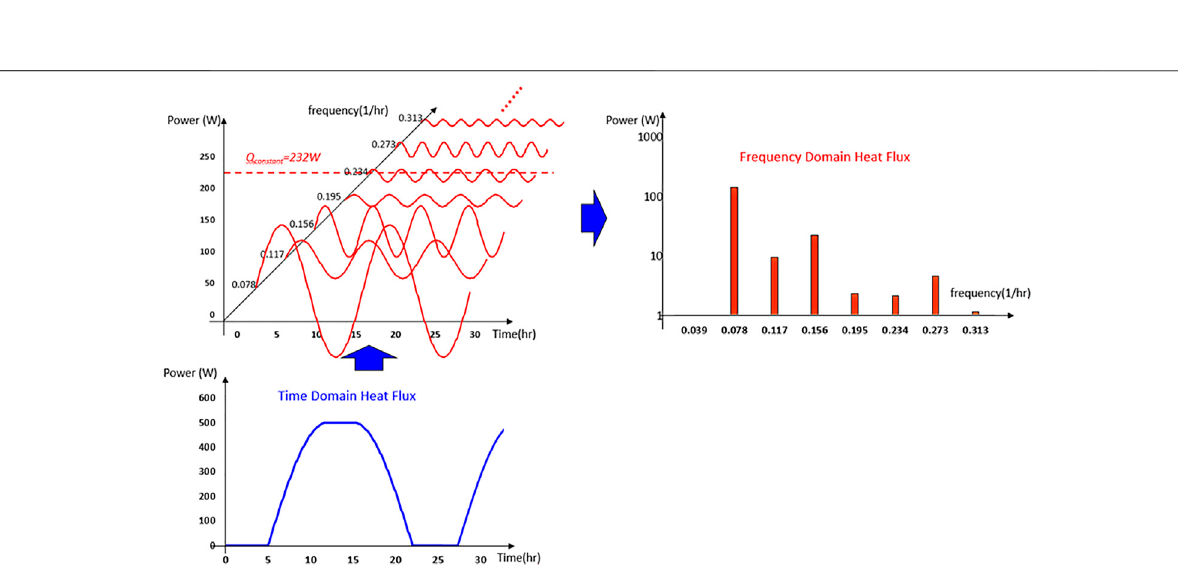
FIGURE 4 | Fourier transform from time domain to frequency